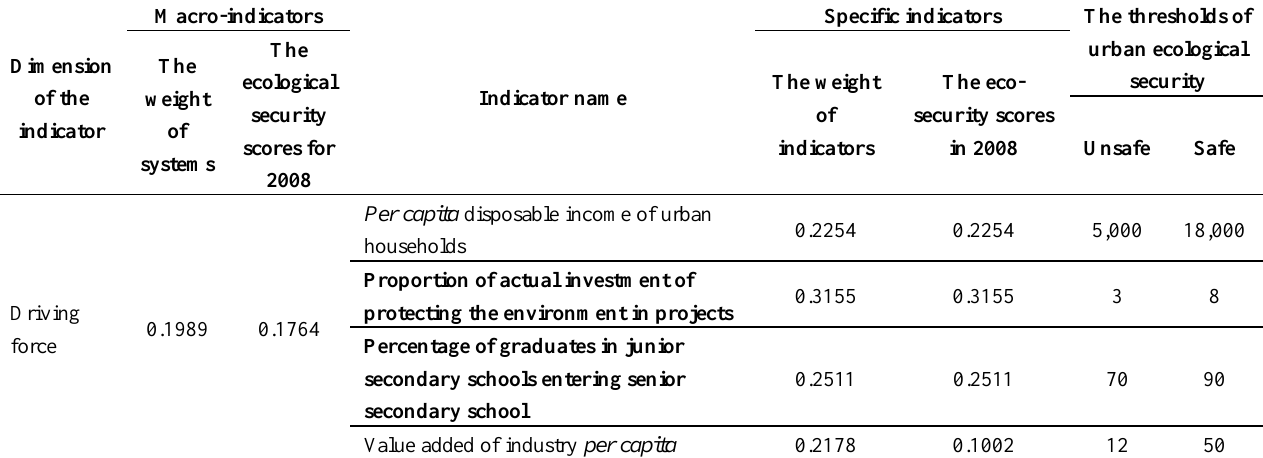
Table 4. The DPSIR framework with the final weights and ecological security